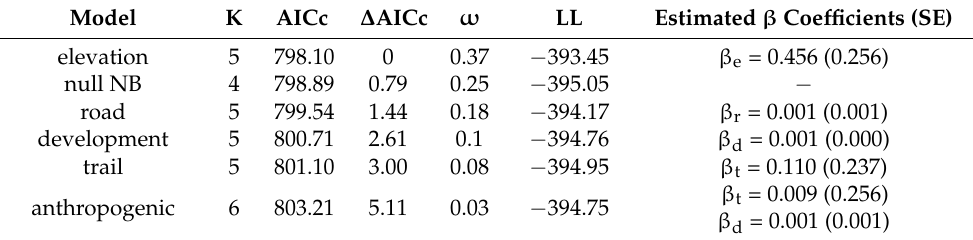
Table 2. Model selection results and estimated β coefficients ( ± SE) relating key deer ( Odocoileus virginianus clavium ) adult doe detection rates to habitat and anthropogenic covariates, from camera trap data collected in the National Key Deer Refuge, Big Pine Key, Florida, USA, 1 May–2 June 2014. Included are the number of model parameters (K, minimum of 4 with detection and abundance intercepts along with trail detection and overdispersion estimates), the Akaike information criterion corrected for small sample size (AICc), the difference from the top model ( ∆ AICc), the Akaike weight ( ω ), and the log-likelihood